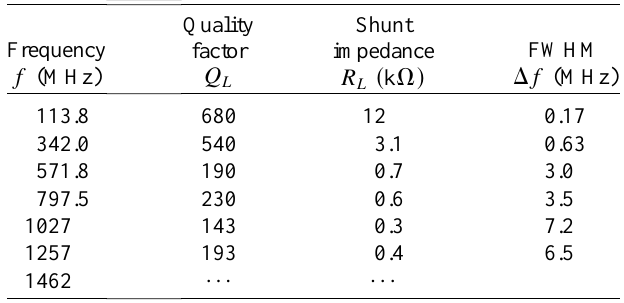
TABLE III. Bench measurements of the SURF rf cavity fun- damental and HOM parameters [32].